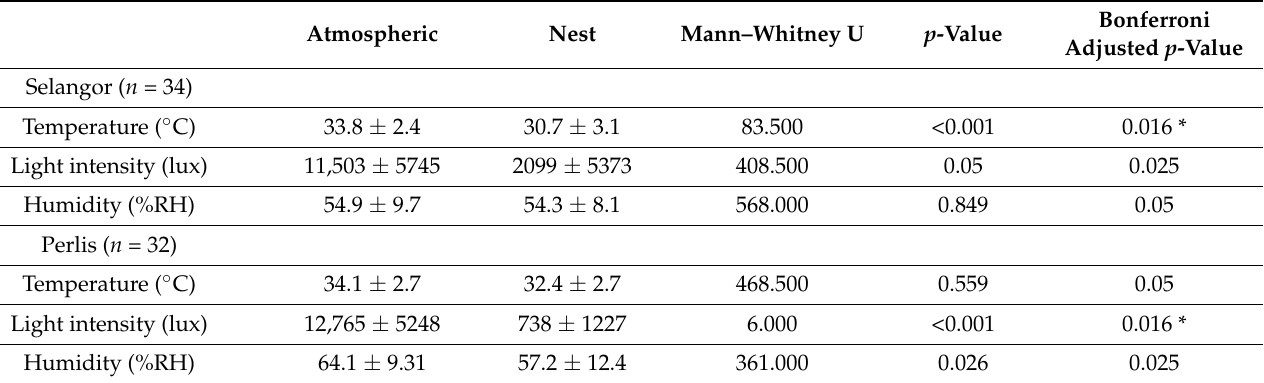
Table 2. Mann–Whitney U tests correlating macroclimate and microclimate variables of active nests of baya weavers ( Ploceus philippinus ) in Selangor and Perlis